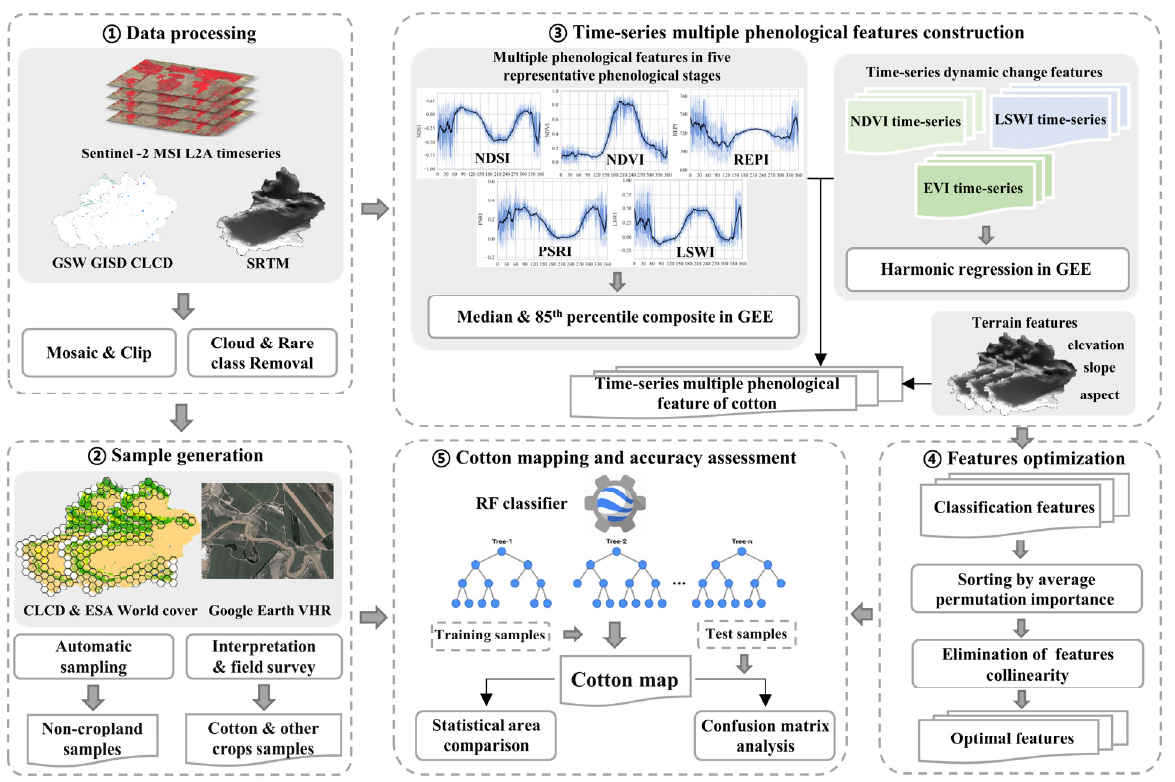
Figure 3. The general framework of cotton mapping. NDSI is Normalized Difference Soil Index, REPI is Red Edge Position Index, PSRI is Three-band Plant Senescence Reflectance Index, LSWI is Land Surface Water Index. Table 1. Formulas of the selected spectral indices with the corresponding phenological stages. Spectral